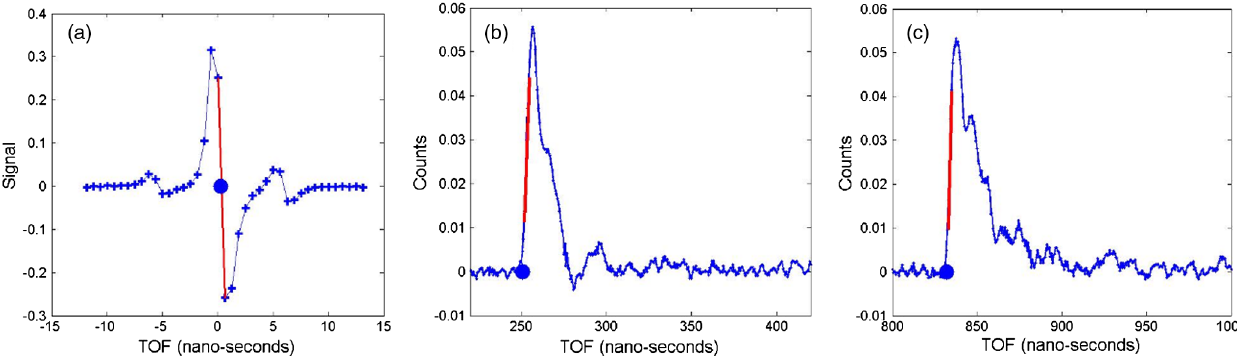
FIG. 11. Waveforms obtained with the 1.6 GHz waveform digitizer: (a) typical BPM waveform, with satellite peaks clearly visible, (b) detector signal for a gamma candidate, (c) detector signal for a neutron candidate. Red lines show the linear fit and the large blue dot the timing obtained by zero crossing with the x